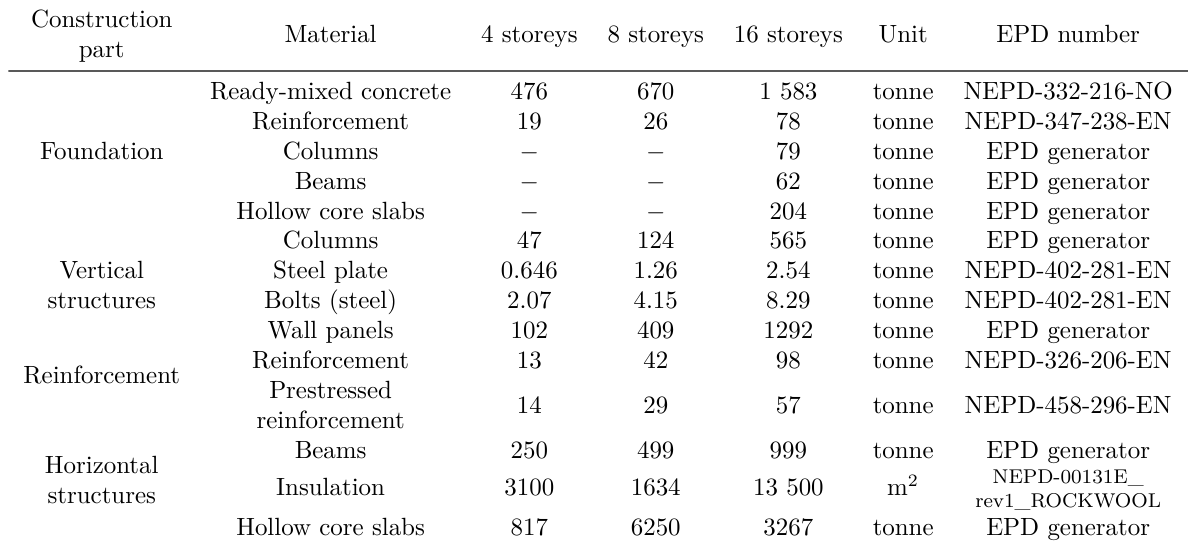
Table 2. Material amounts for the pre-cast concrete-based load-bearing